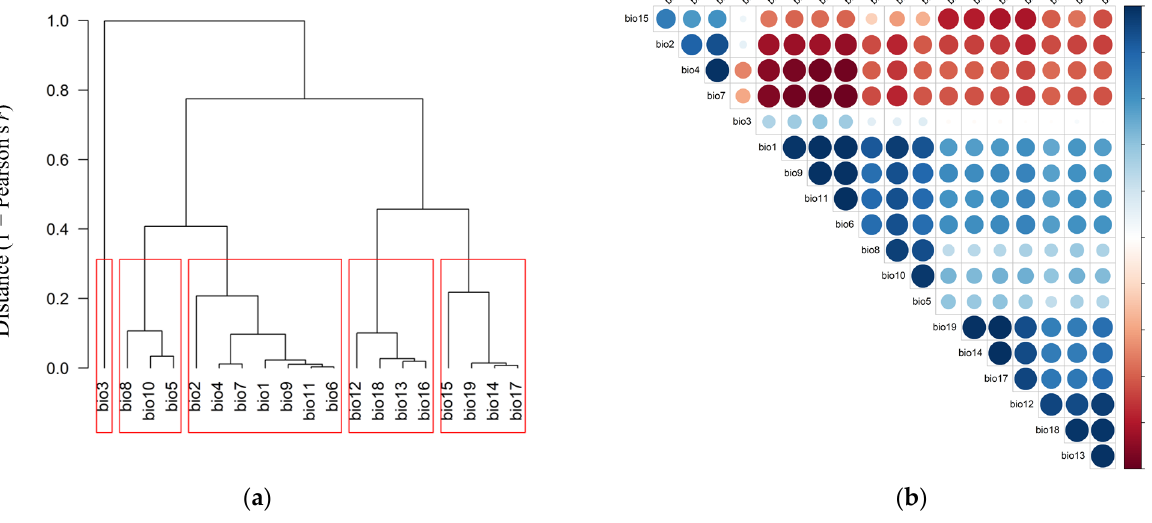
Figure 1. ( a ) Pearson correlations of 19 bioclimatic variables. The variables with correlation coeffi- cients of more than 0.7 were excluded. ( b ) Analysis of 19 climatic factors’ Pearson correlations. The red dots represent positive correlations, and the black dots represent negative correlations. The darker the color and the larger the circle are, the greater the correlation was. If there was no correlation, there is no color.